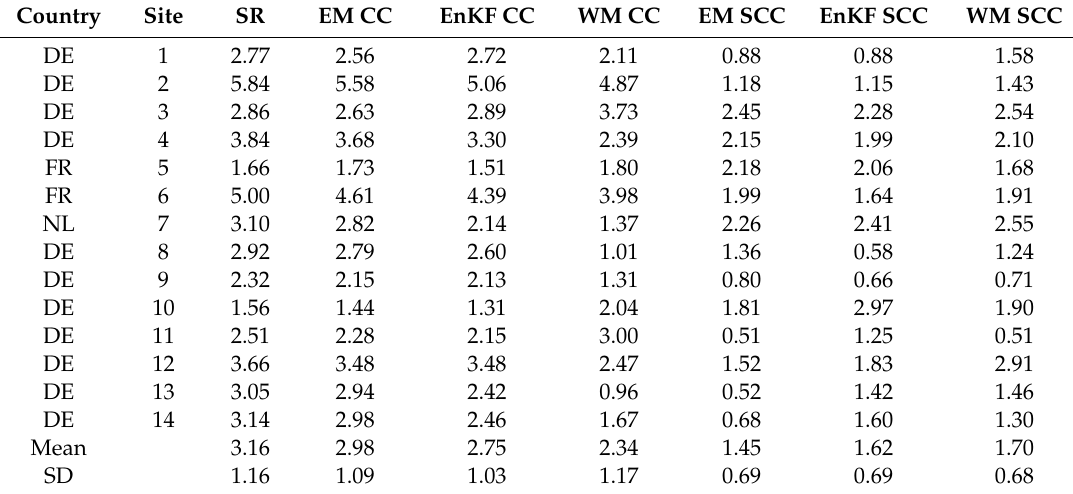
Table 4. RMSE results for grain yields. SR: Standard Run, EnKF: Ensemble Kalman Filter, WM: Weighted Mean, EM: Ensemble Mean, CC: Crop Component Set, SCC: Soil and Crop Component Set. All values in t ha − 1 . DE: Germany, FR: France, NL: